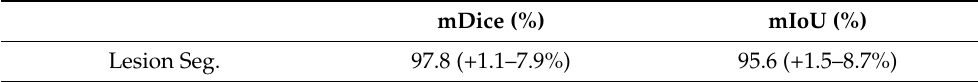
Table 2. Results on lesion segmentation. Mean dice, IoU and their 95% confidence